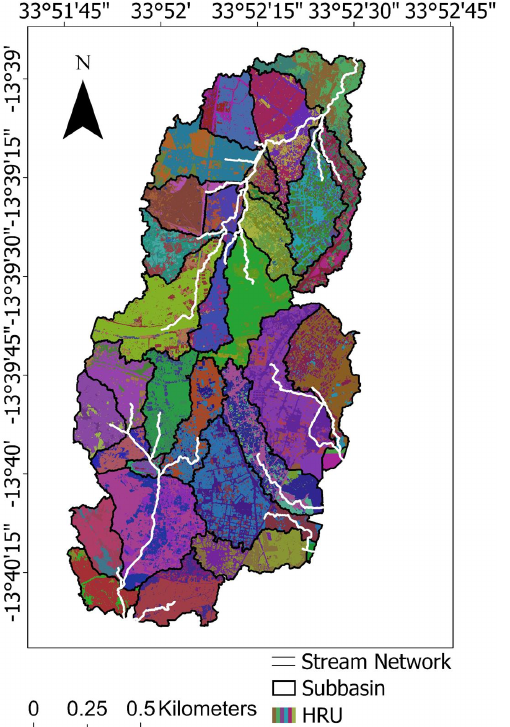
Figure 12. The initial SWAT output contains 34 subbasins (black outlines) based on the stream network (white lines) and 135 HRUs (colors).